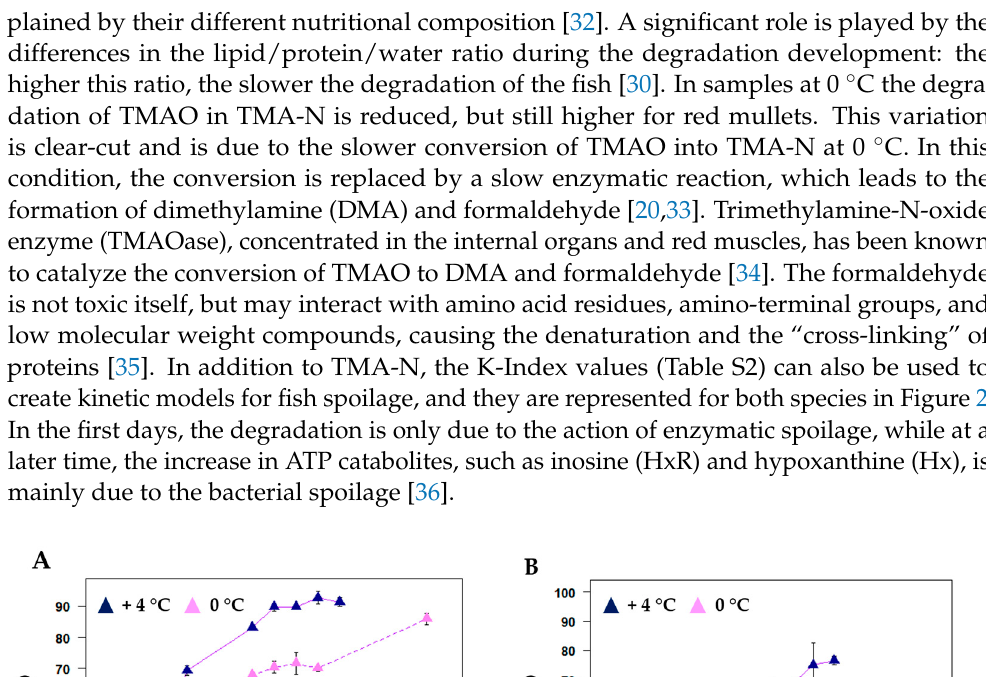
Figure 1. Kinetic of TMA-N concentrations (mg/100 g) for ( A ) red mullet ( Mullus barbatus ) and ( B ) bogue ( Boops boops ) samples during the storage at both +4 °C and 0 °C. All the concentrations were calculated via NMR by using the protocol fine-tuned by Ciampa et al. [8].